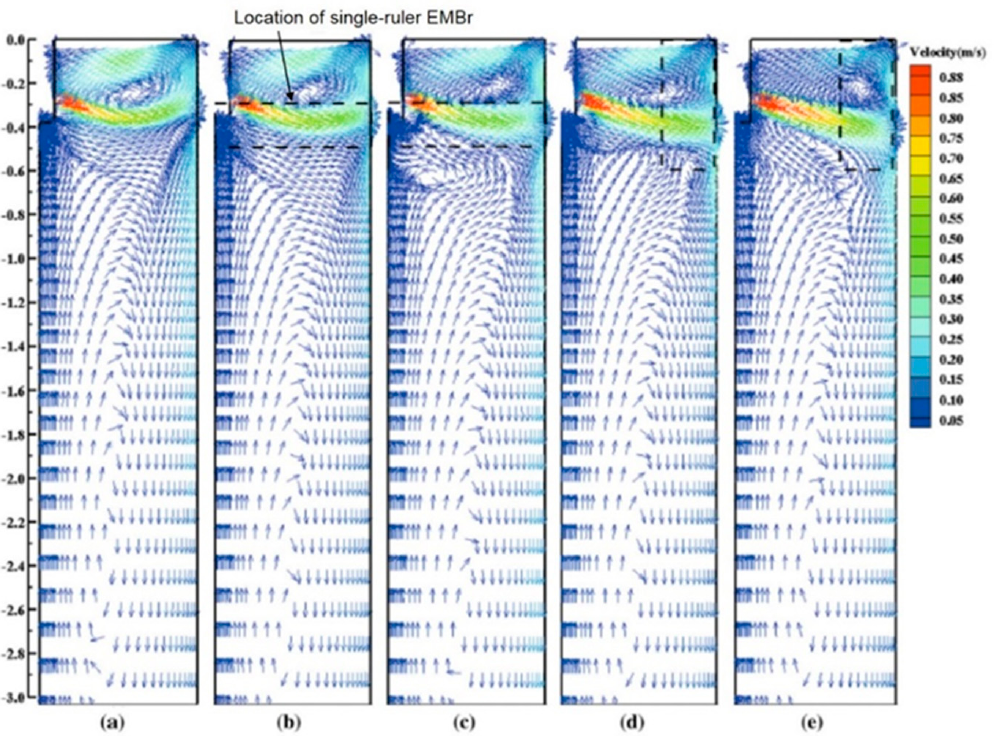
Figure 11. Mold flow pattern ( a ) with no magnetic field, ( b ) horizontal single-ruler EMBr 0.1 T, ( c ) 0.2 T, ( d ) vertical single-ruler EMBr 0.1 T, and ( e ) 0.2 T [109].